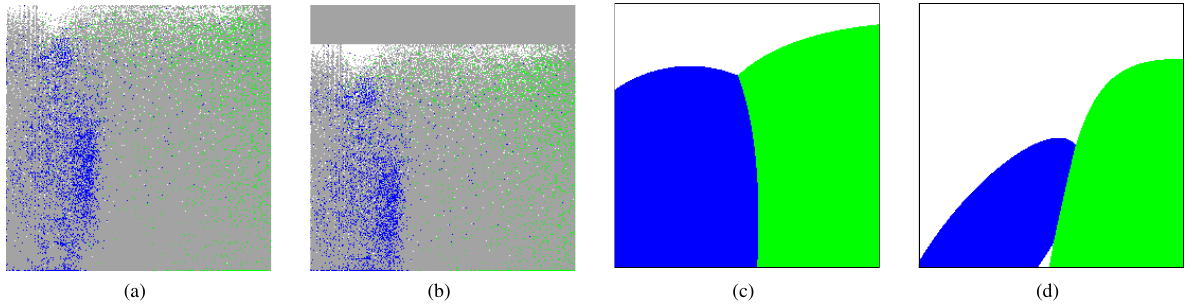
Figure 2: Feature space from source (a) and target (b) domains; decision boundaries for after training the classifier on source domain data (c); decision boundaries in the target domain after TL (d). Colours: impervious surfaces (white), building (blue) and tree (green).